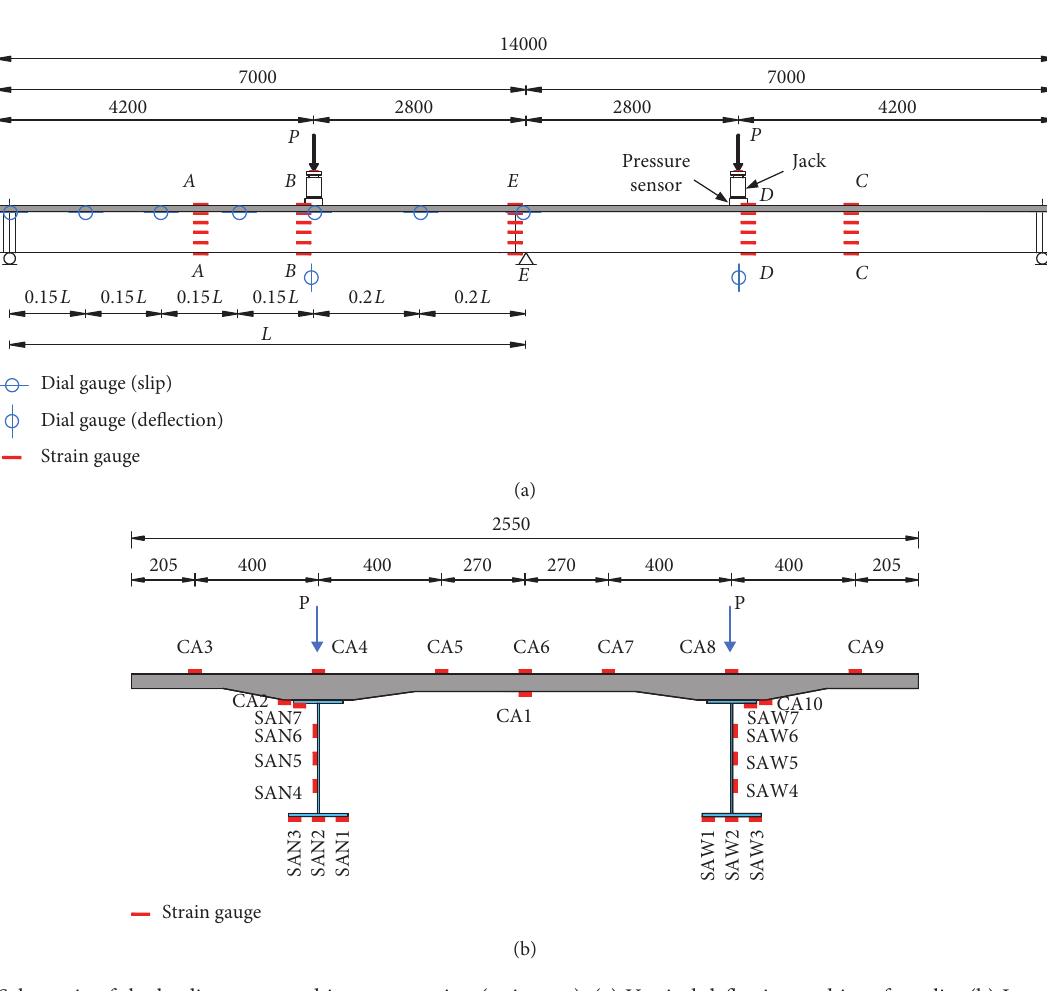
Figure 5: Schematic of the loading setup and instrumentation (unit: mm). (a) Vertical deflection and interface slip. (b) Layout of strain gauges on the steel girder and concrete slab (section A